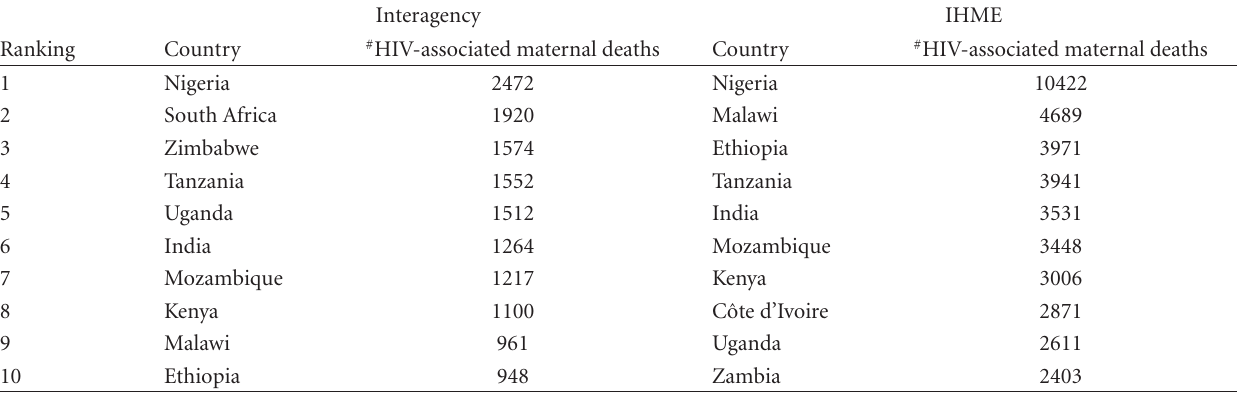
Table 2: 10 Countries with the highest number of HIV-associated maternal deaths, 2008, by model.